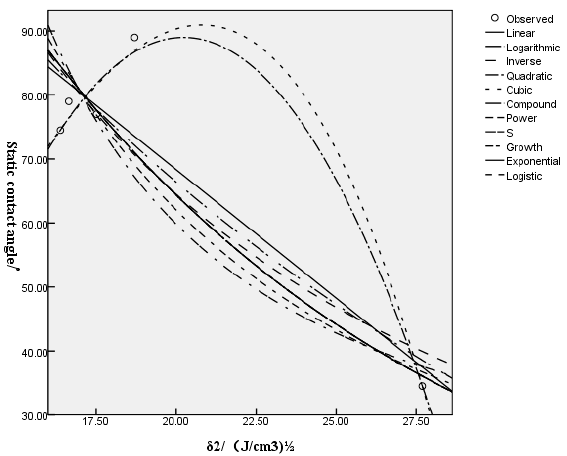
Figure A2. Model summary between the solubility parameter and contact angle.